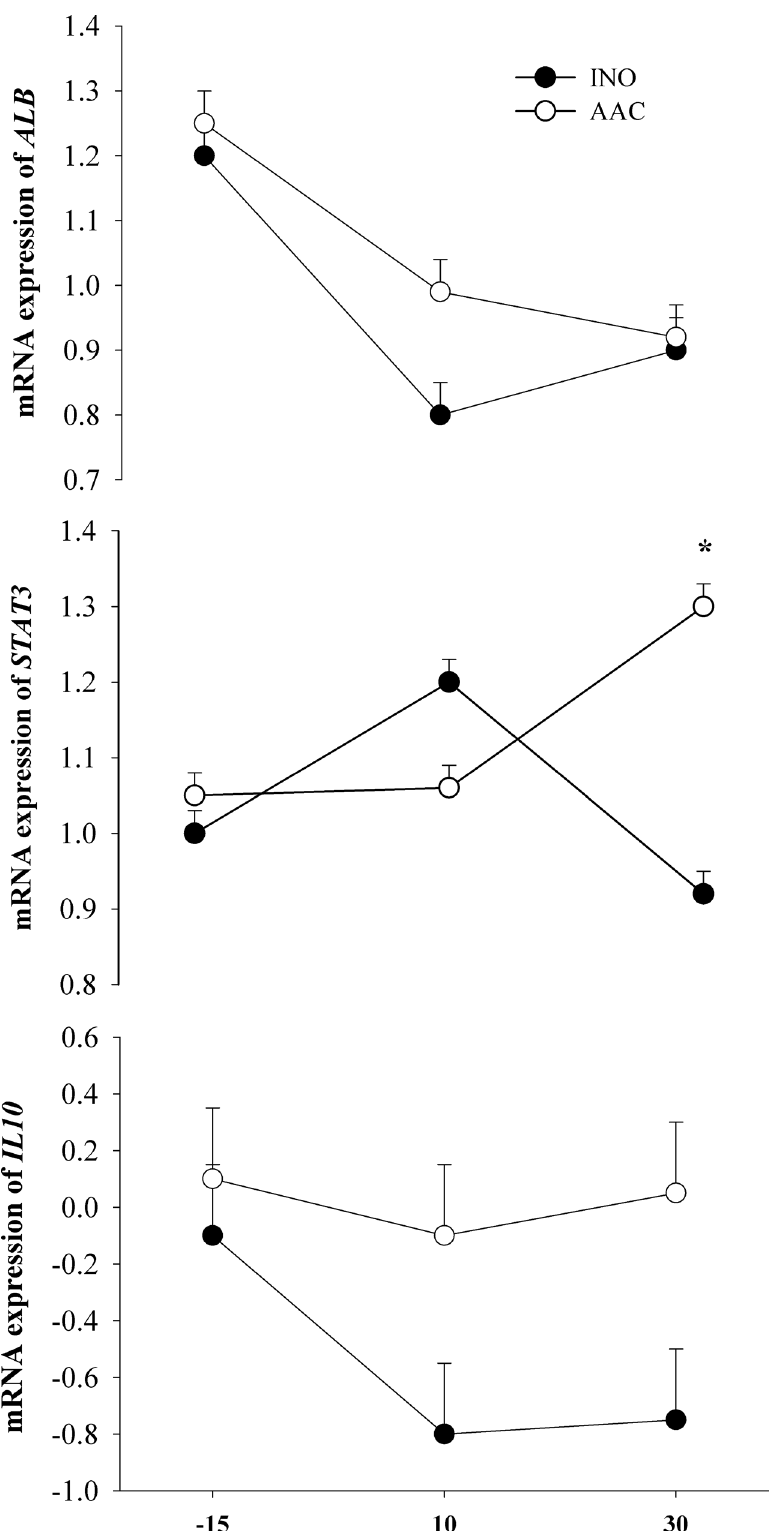
Fig 4. Effects of supplementing cows with inorganic (INO; n = 11) or organic (AAC; n = 9) trace minerals during the pre and postpartal periods on hepatic mRNA expression of genes related